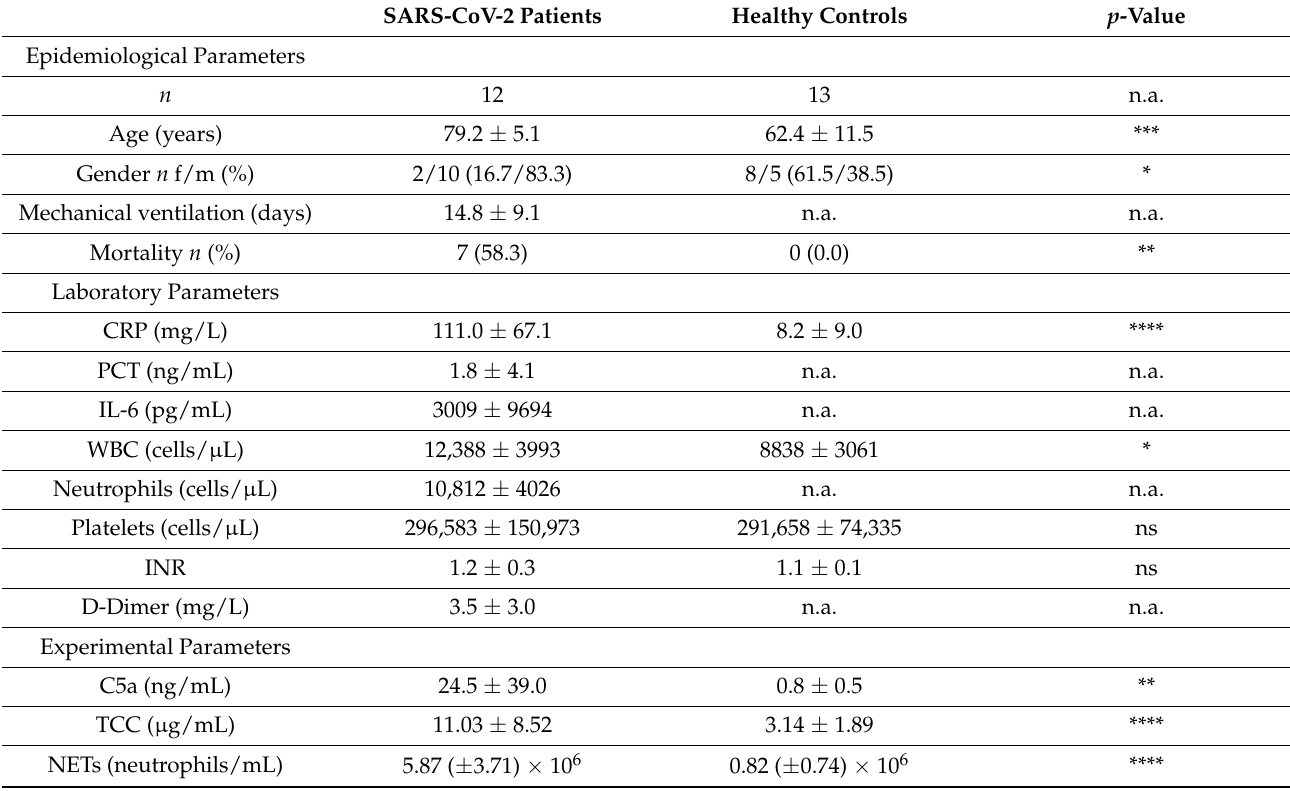
Table 1. Characteristics as well as systemic and experimental laboratory blood parameters of patients and healthy controls. Values represent baseline parameters acquired at first sampling time point. Data are presented as mean ± SD or n (percentage). Differences between both groups were analyzed by unpaired t -test, Mann–Whitney U test, or Fisher’s exact test, as